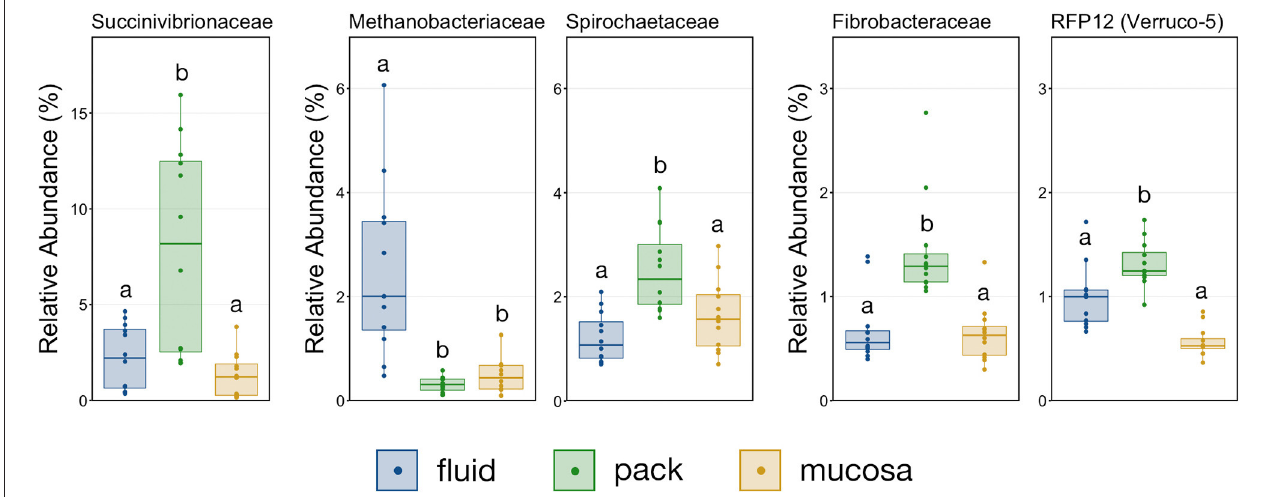
FIGURE 8 | Boxplot demonstrating the relative abundances of the five families outside of Bacteroidetes and Firmicutes that are discriminant of a ruminal micro-environments. Points represent individual animals, and the horizontal line in each boxplot represents the median relative abundance. Significant differences between the relative abundances of each family are illustrated by different letters (Pairwise Wilcoxon rank-sum with Benjamini-Hochberg correction, p < 0.05, n =